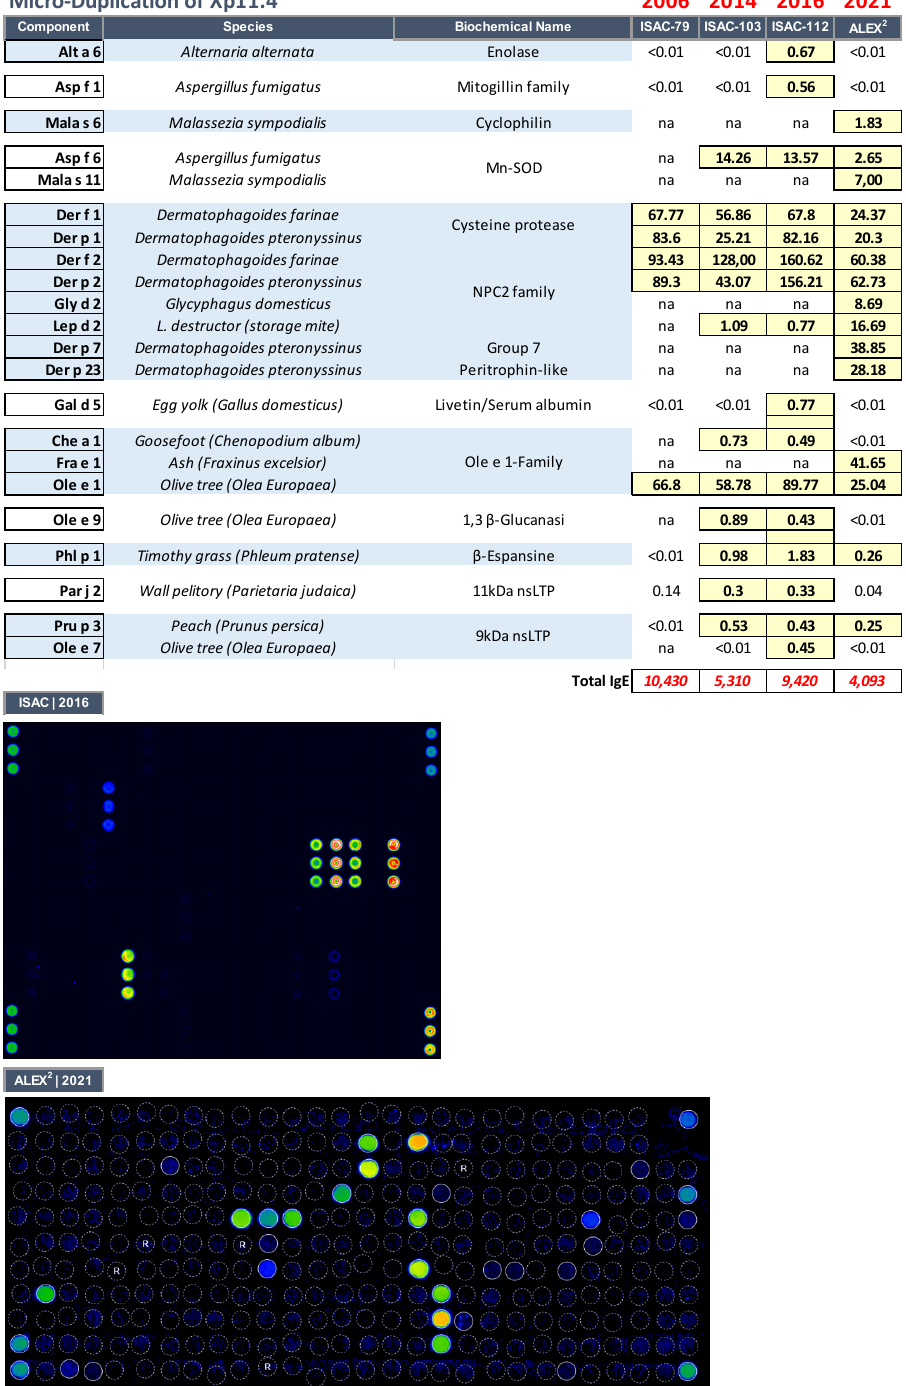
Figure 4. IgE sensitization profile as evaluated through multiplexed proteomic serial evaluations with ImmunoCAP ISAC ® microarray (2006, 2014, and 2016) and Allergy Explorer–ALEX2 ® macroarray (2021), in the patient affected by a microduplication of Xp11.4.